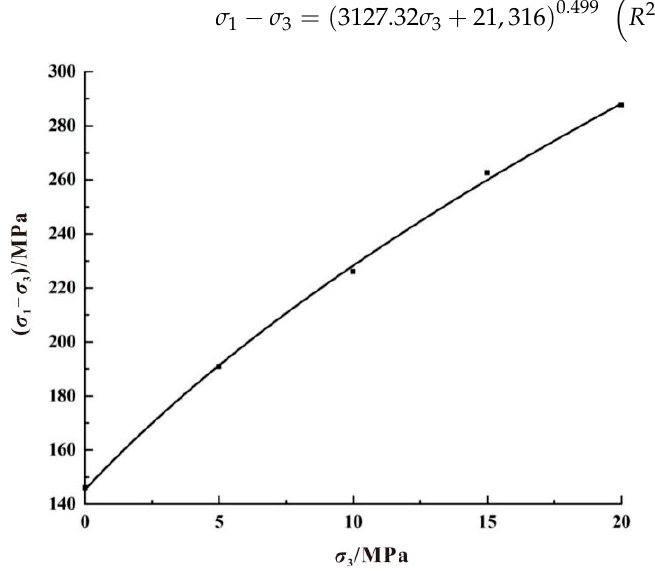
Figure 8. The fitting curve using Hoek–Brown strength criterion.